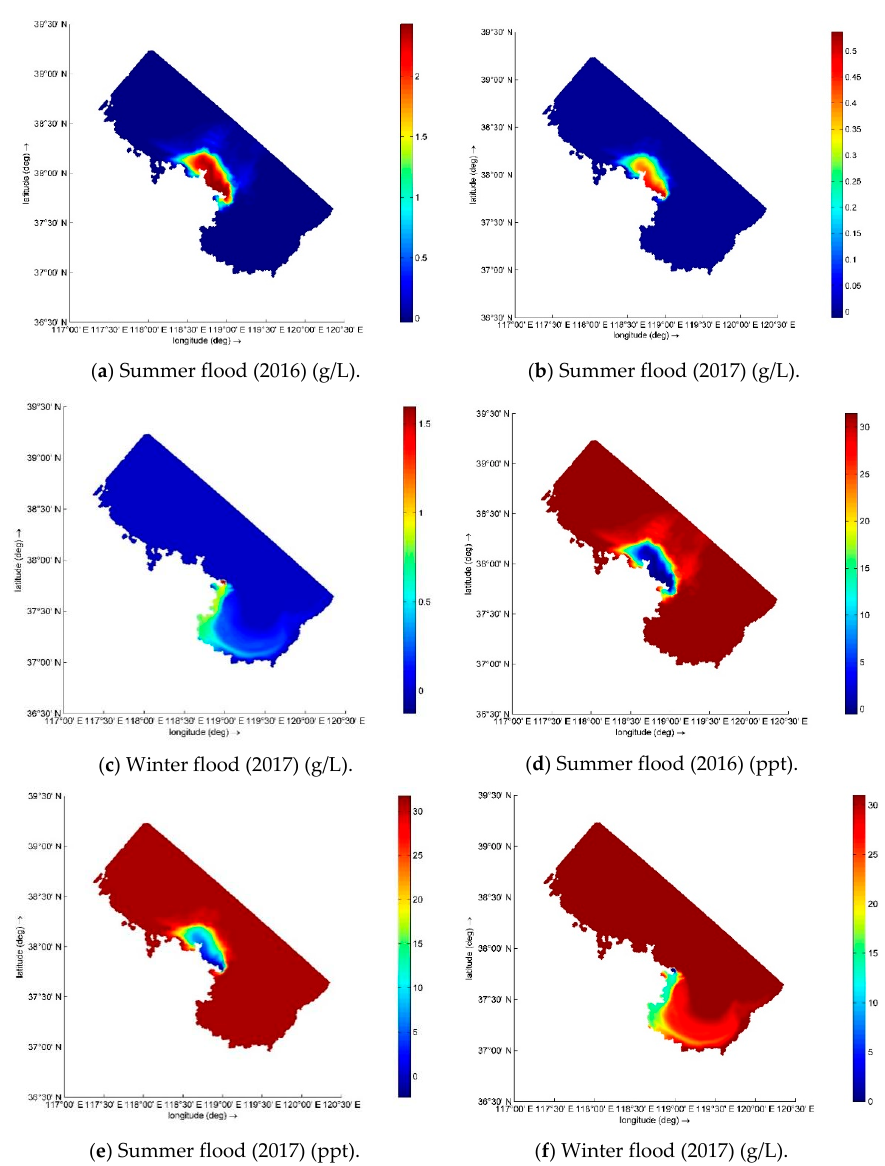
Figure 7. The diffusion of suspended sediment ( a – c ) and water ( b – f ) in the Yellow River delta during the summer flood periods in 2016 ( a , d ) and 2017 ( b , e ), and the winter flood period in 2017 ( c , f ). The simulation results showed that most of the sediment from the Yellow River was deposited in the estuary area, and part of the sediment spread to adjacent sea areas under the combined action of wind, waves, and currents. As shown in Figures 8 and 9, in the absence of wind influence, the incoming water and sediment mainly gathered near the es- tuary, and a small part was transported to the southeast of Laizhou Bay (Figures 8a and 9a). Based on this, it was speculated that during the period of the northerly wind, the effect of the wind was beneficial to the diffusion of sediment. The simulation results showed that